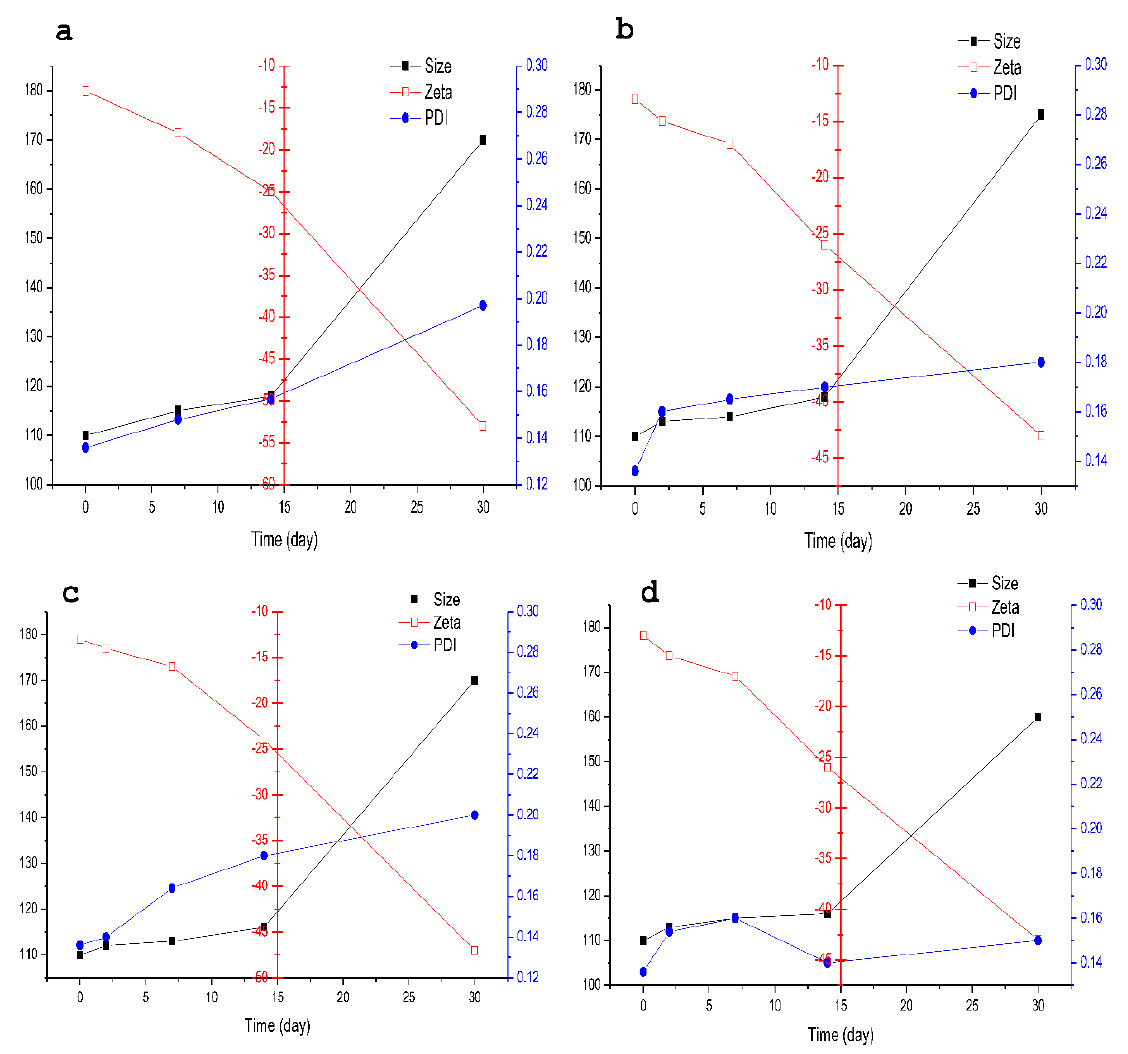
Figure 4. Particle size, zeta potential, and PDI of osthol nanoparticle suspensions and powder suspensions. Suspensions ( a ) at light intensity of 3000 lx for 30 days and ( b ) at 60 °C for 30 days. Power ( c ) at light intensity of 3000 lx for 30 days and ( d ) at 60 °C for 30 days.